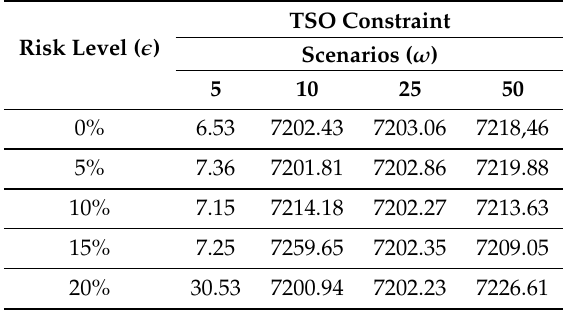
Table 2. Computational effort under Big-M method in seconds